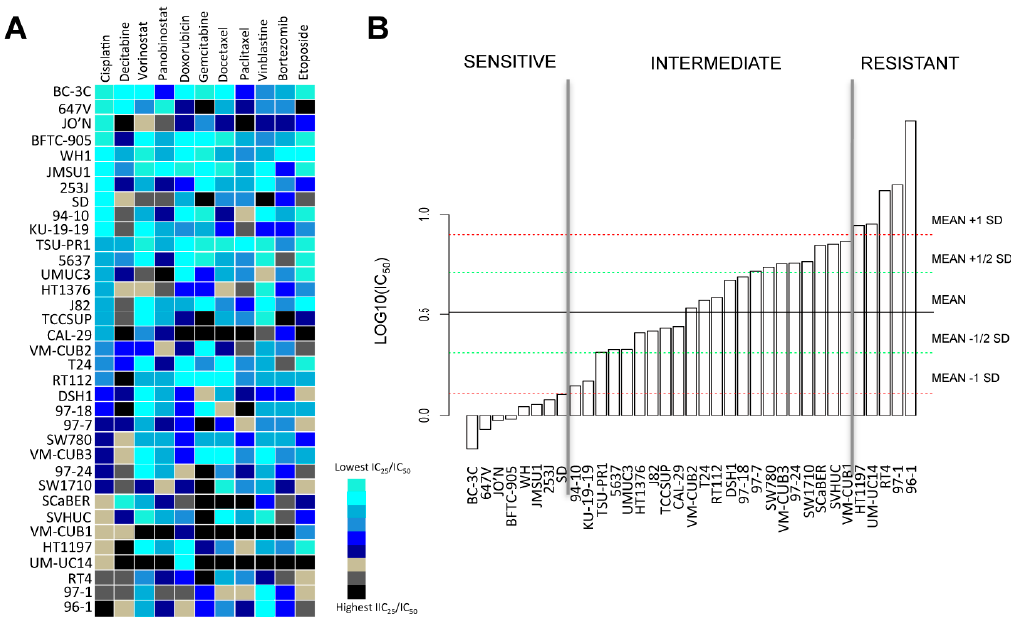
Figure 1. Drug screening reveals sensitivity and resistance of 35 bladder cancer cell lines to decitabine and standard chemotherapeutic agents with effects in bladder cancer. ( A ) Distinct 25%/50% inhibitory concentration (IC 25 /IC 50 ) values for cisplatin and chemotherapy drugs are observed in the panel of 35 bladder cancer cell lines treated for 48 h with the respective agents. Cell lines are ranked (from lowest to highest, from top to bottom) on the basis of IC 25 /IC 50 values for cisplatin. Color scale is normalized for each drug. Note that there is no correlation between resistance towards cisplatin and resistance towards decitabine (5 ‐ AZA ‐ CdR); ( B ) Bladder cancer cell lines segregate into sensitive, intermediate and resistant groups according to their sensitivity to cisplatin. Sensitive cell lines: IC 50 < average (IC 50 ) − 1 SD (standard deviation); resistant cell lines: IC 50 > average (IC 50 ) + 1 SD. Experiments were run in triplicates to obtain mean IC 50 values.